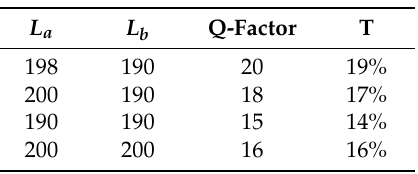
Table 1. Effect of fabrication tolerance on L a and L b on the nanocavity